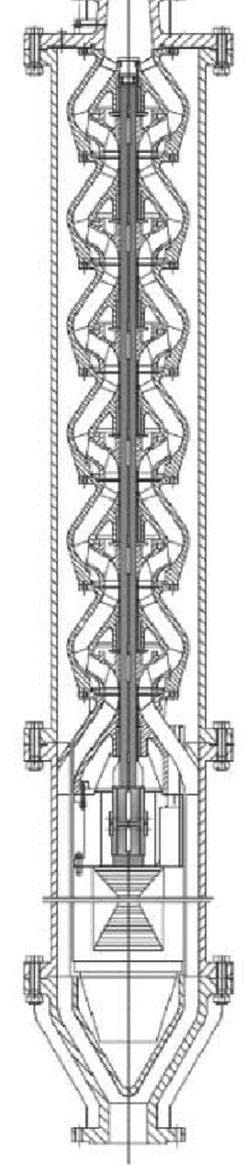
Figure 2: Structure of ore slurry pump for